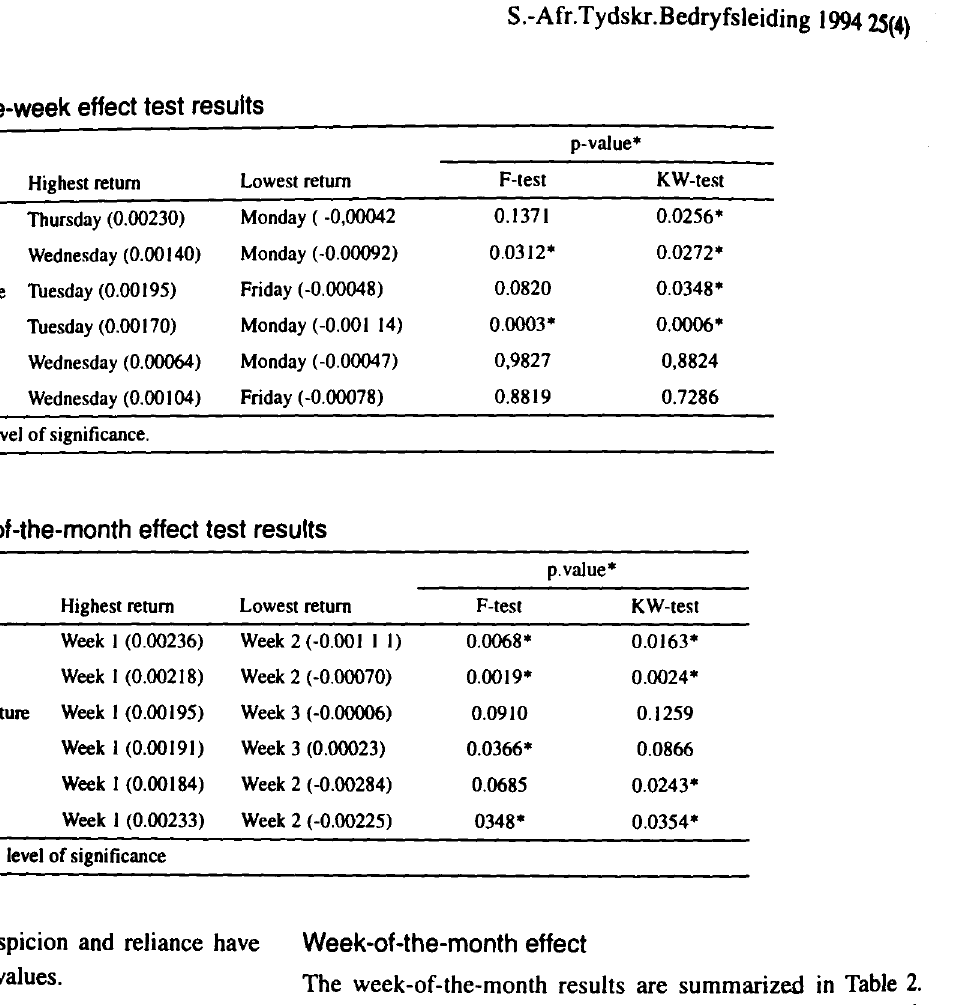
Table 2 Week-of-the-month effect test